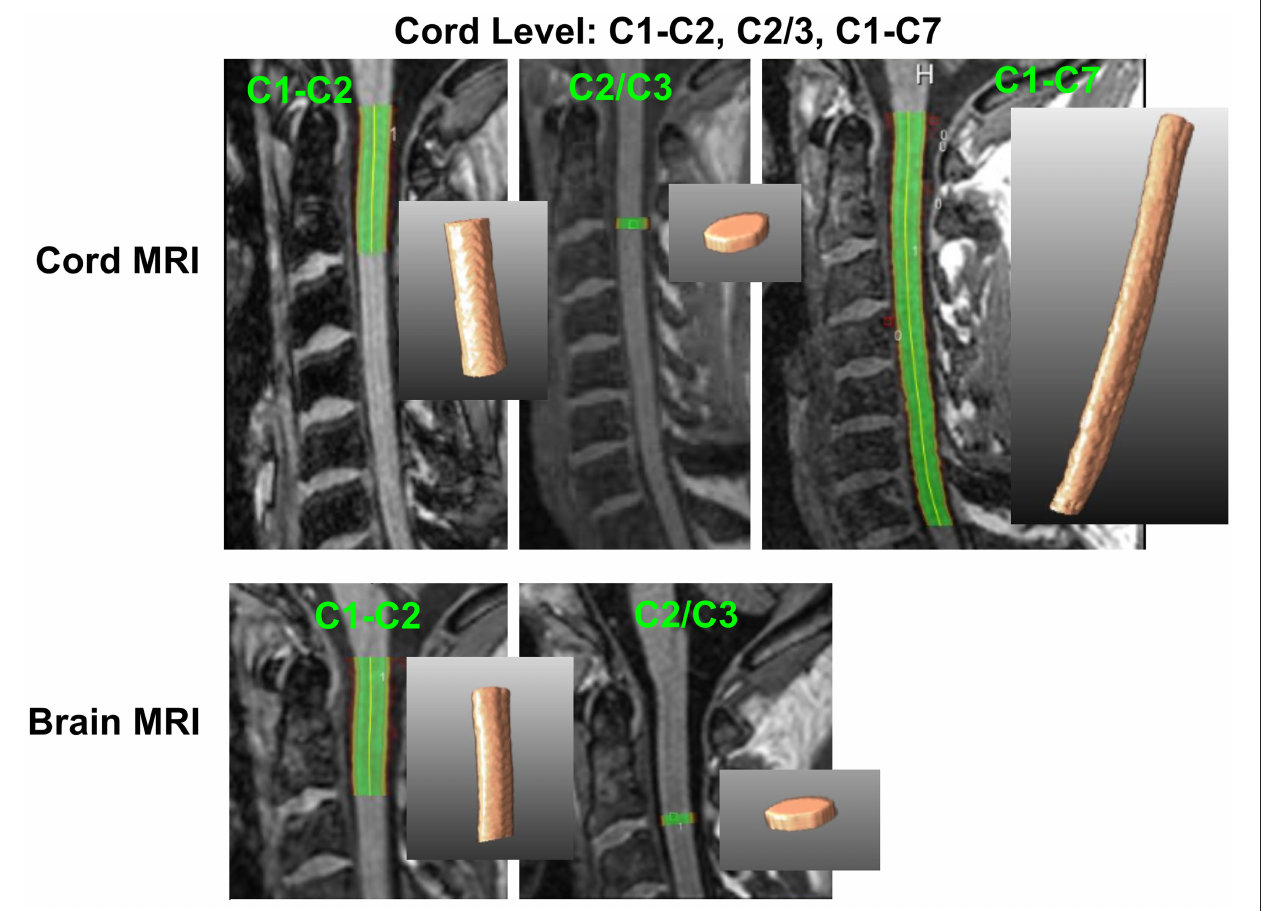
FIGURE 1 | Definition of cervical cord level measurements on brain and cord MRI. C1–C2, upper cervical cord between C1 and C2 vertebra; C2/3, 3-mm slab at the C2/C3 disc level; C1–C7, entire cervical cord between the C1 and C7 vertebral level. 2D and 3D segmentations based on NQL are shown as examples.